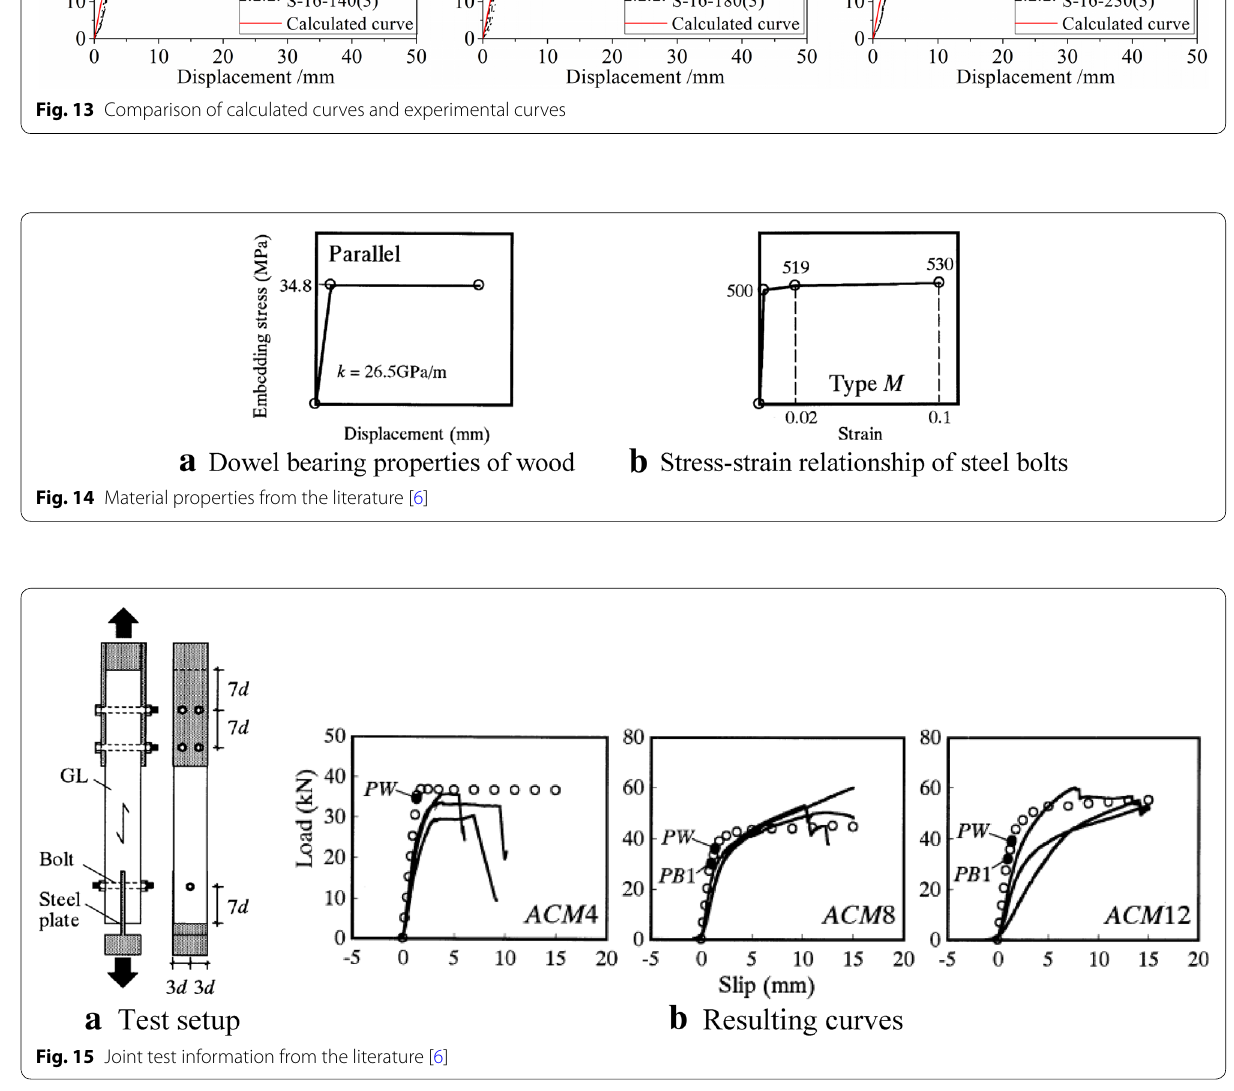
discussed as follows: (1) When the rotation of the bolt midpoint ( x 0) is fully constrained ( θ 0 (32) k e = = 0 tute θ 0 into formulas (24), (28), and (30) and solve = 2 them to obtain β ; (2) when the rotation of the bolt midpoint ( x 0) is not fully constrained ( M 0 =